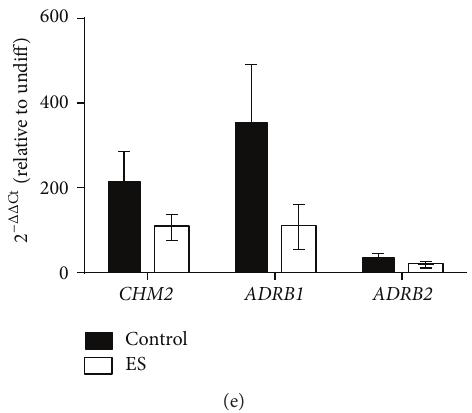
Figure6:ElectrophysiologicalpropertiesofcardiomyocytesderivedfromiPS(Foreskin)-2cellline. (a)BeatingEBsatday14afterplatingwere cycling calcium. Intensity of fluorescence has been normalized with background. (b) A representative image of a microelectrode array with beating pieces and the extracellular field potential recorded. (c) The percentage change in beating rate and (d) the cFPD of cardiomyocytes from control and electrically stimulated (ES, 200mV/mm, 5min) groups treated with isoproterenol hydrochloride (isoprenaline, 1–1000 nM) or carbamylcholine (carbachol, 1–1000nM) ( 𝑛 = 3 independent experiments). (e) Quantitative RT-PCR analysis for the expression of muscarinicreceptor 2 ( CHM2 ), 𝛽 -adrenergicreceptor-1 ( ADRB1 ),and 𝛽 -adrenergicreceptor-2 ( ADRB2 )in control and electrically stimulated beating EBs ( 𝑛 = 4 –7 independent experiments). ES: electrically stimulated and undiff: undifferentiated iPSCs. Data are expressed as mean ± SEM. ∗ 𝑝 < 0.05 , ∗∗ 𝑝 < 0.01 , and ∗∗∗ 𝑝 < 0.001 by one-way ANOVA with the Bonferroni post hoc